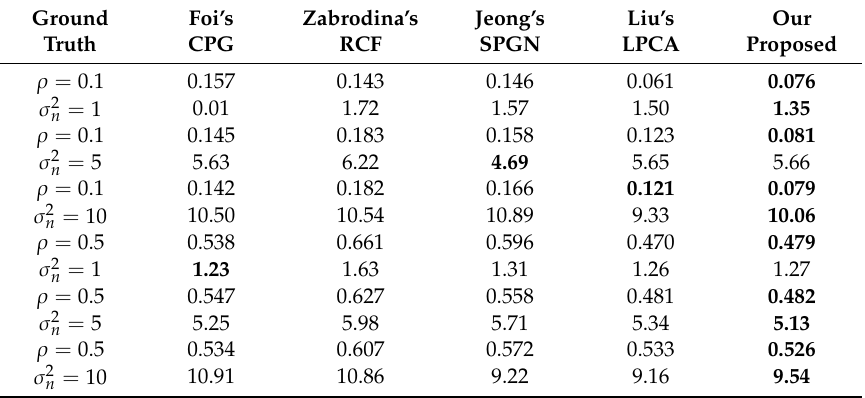
Table 6. The results of di ff erent PGN estimation algorithms on the BSD images. Ground